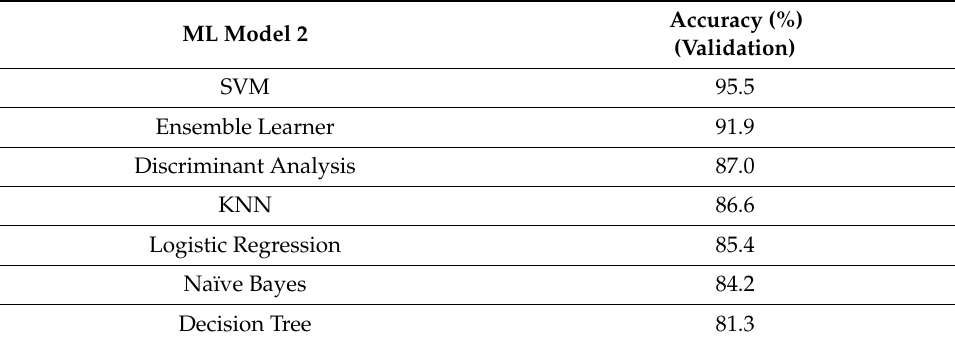
Table 8. Results of the stumble-type classification problem (validation).